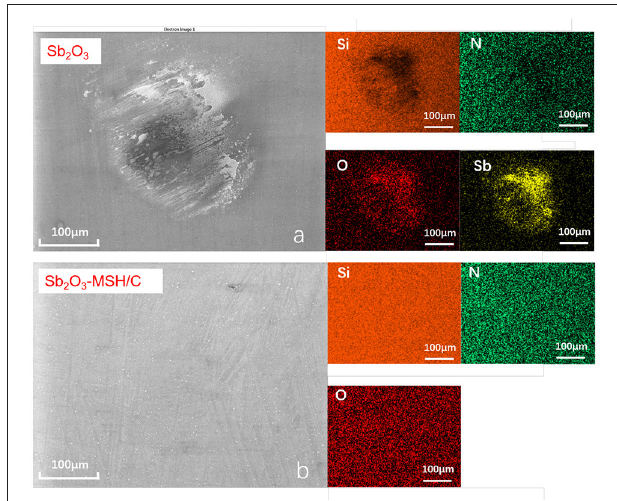
FIGURE 7 | The SEM and the corresponding EDS elementap mapping images of the wearmarks for the silicon nitride balls after the tests performed at 300 ◦ C for (a) Sb 2 O 3 and (b) Sb 2 O 3 -MSH/C